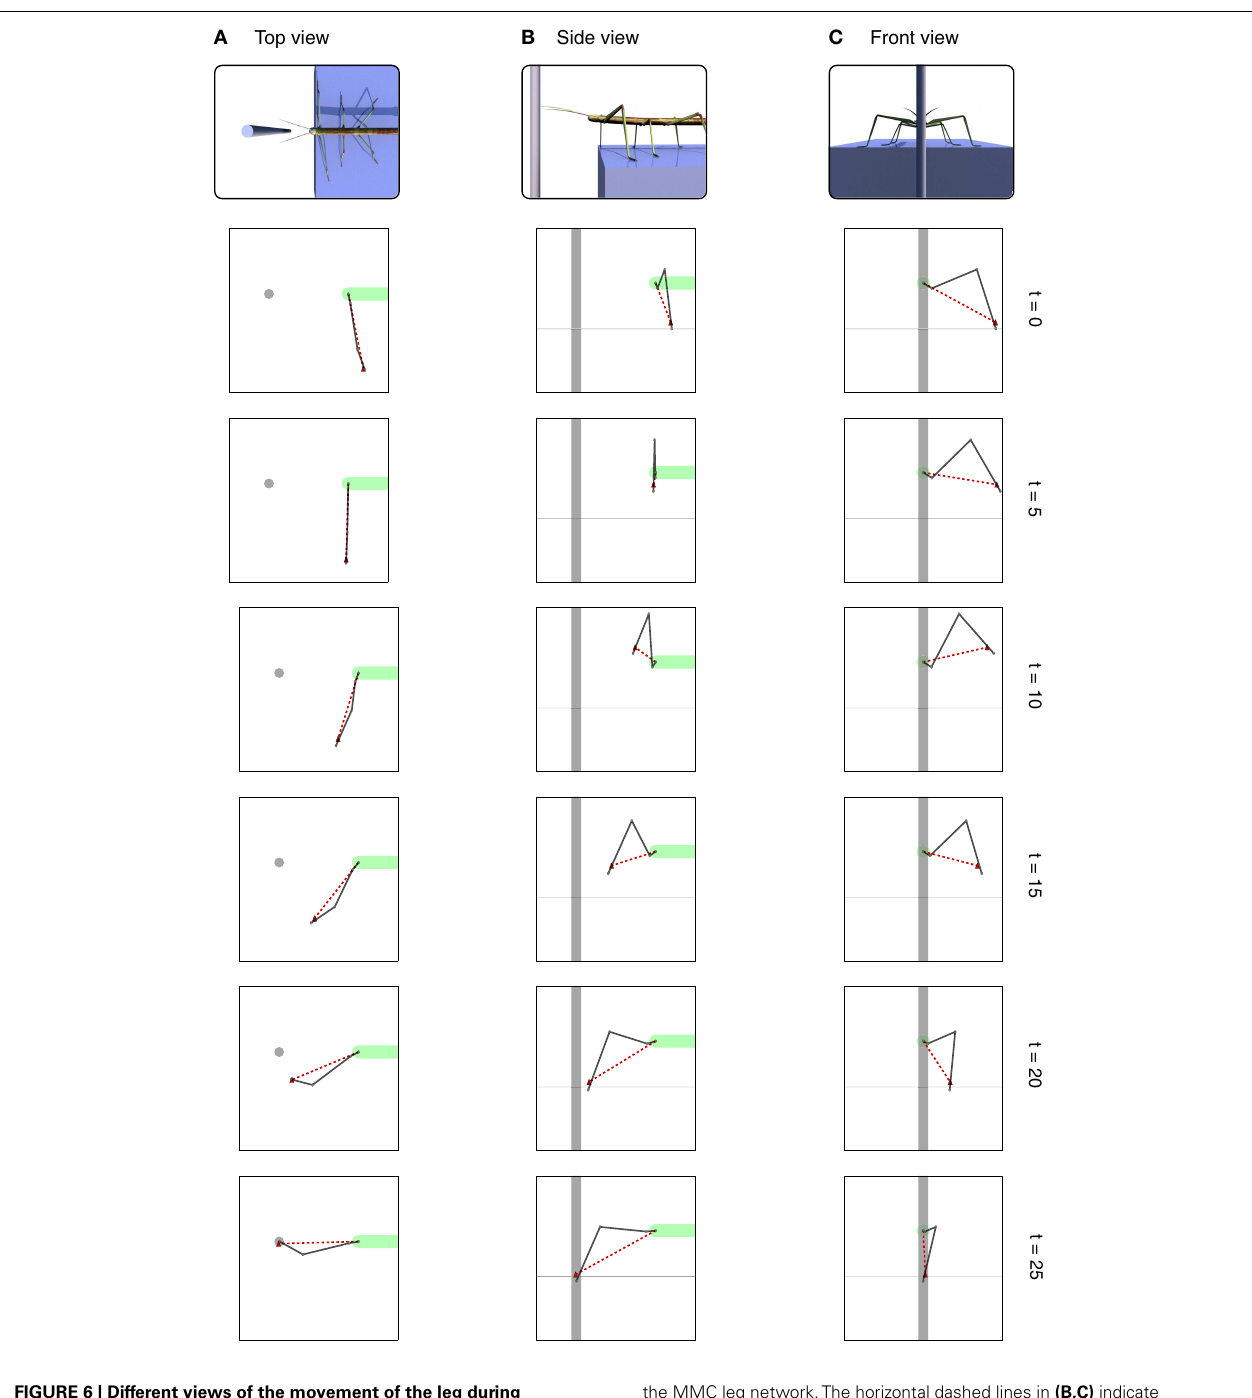
FIGURE 6 | Different views of the movement of the leg during the search movement. The dark solid line always shows the current leg configuration as described through the joint angles.The red dashed line shows the position of the tarsus as estimated by